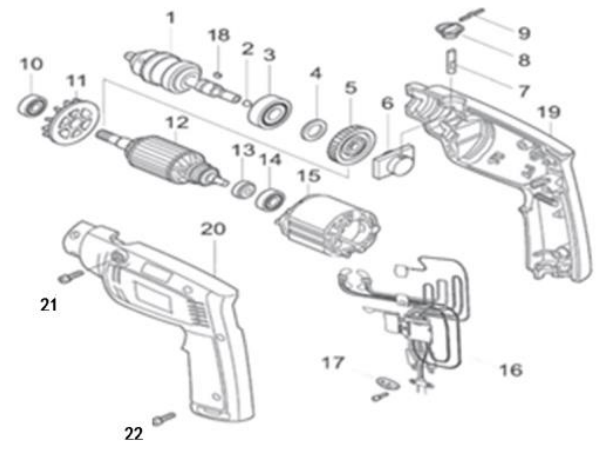
Figure A2. Schematic diagram of a hammer drill [12].